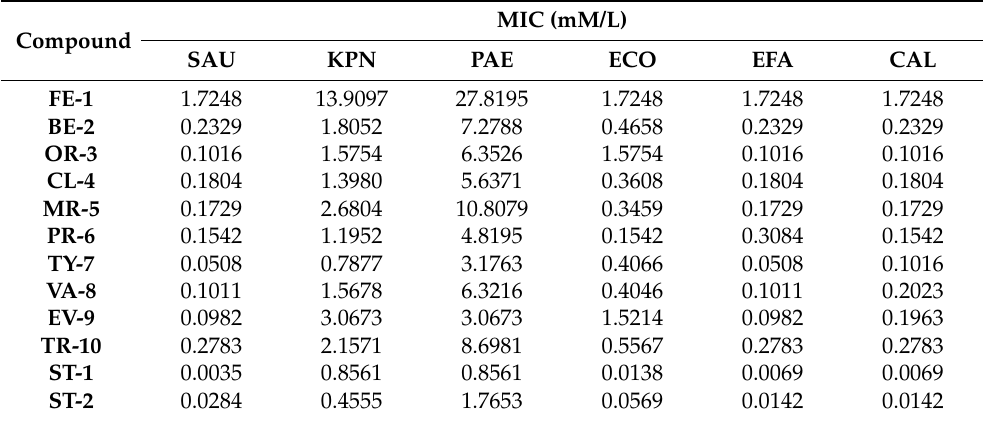
Table 4. MIC values of the group of new